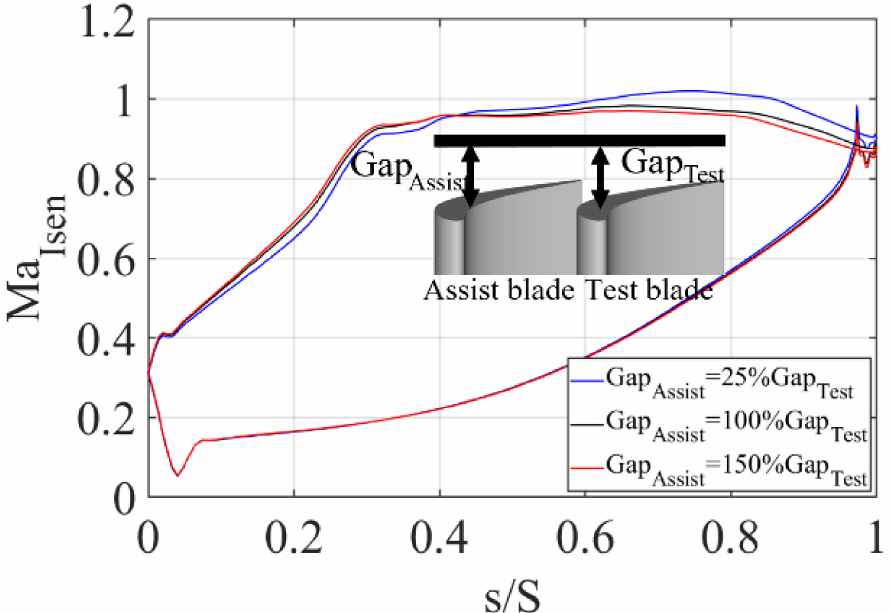
Figure 4. Isentropic Mach number distributions of Test blade 97%span surface for three assist blade tip gap (25% Gap Test ,100% Gap Test ,150% Gap Test ) cases.